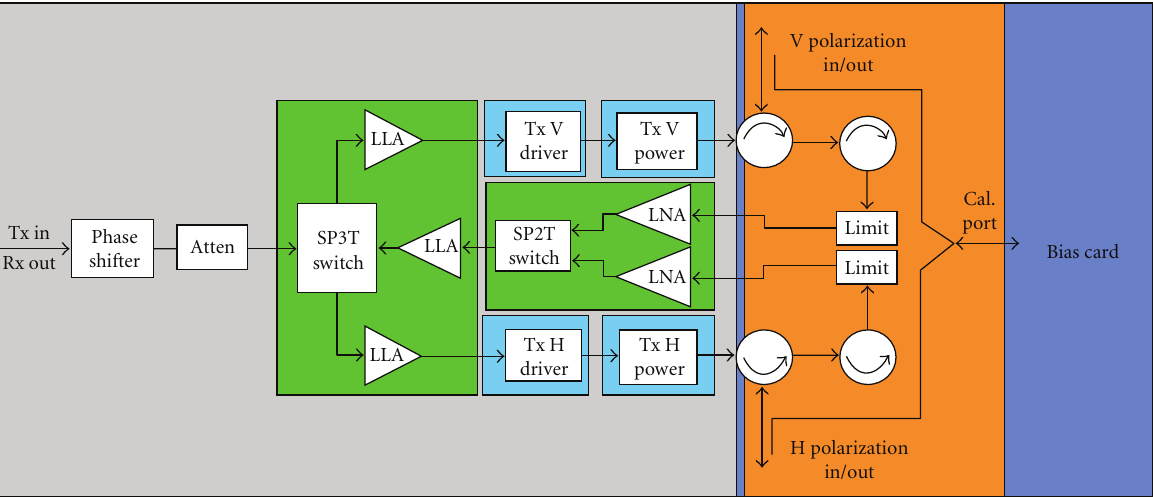
Figure 8: T/R module and RF layout.